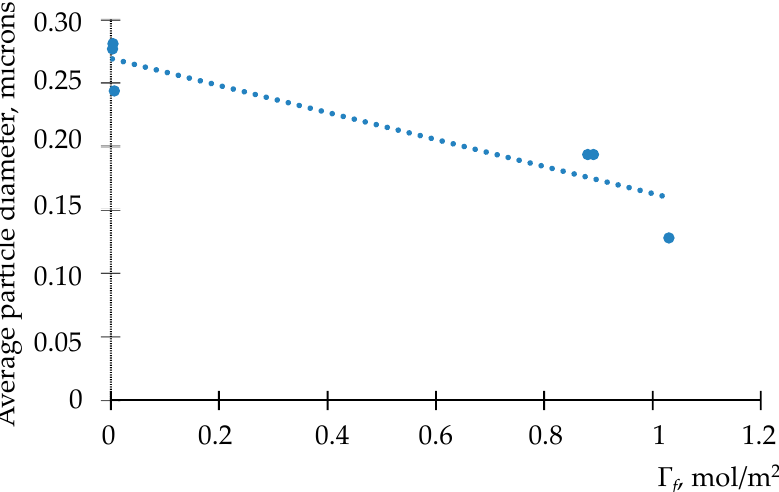
Figure 7. Dependency of the CNPLUS size on the value of specific adsorption on the surface in the system “CNPLUS–surfactant”.